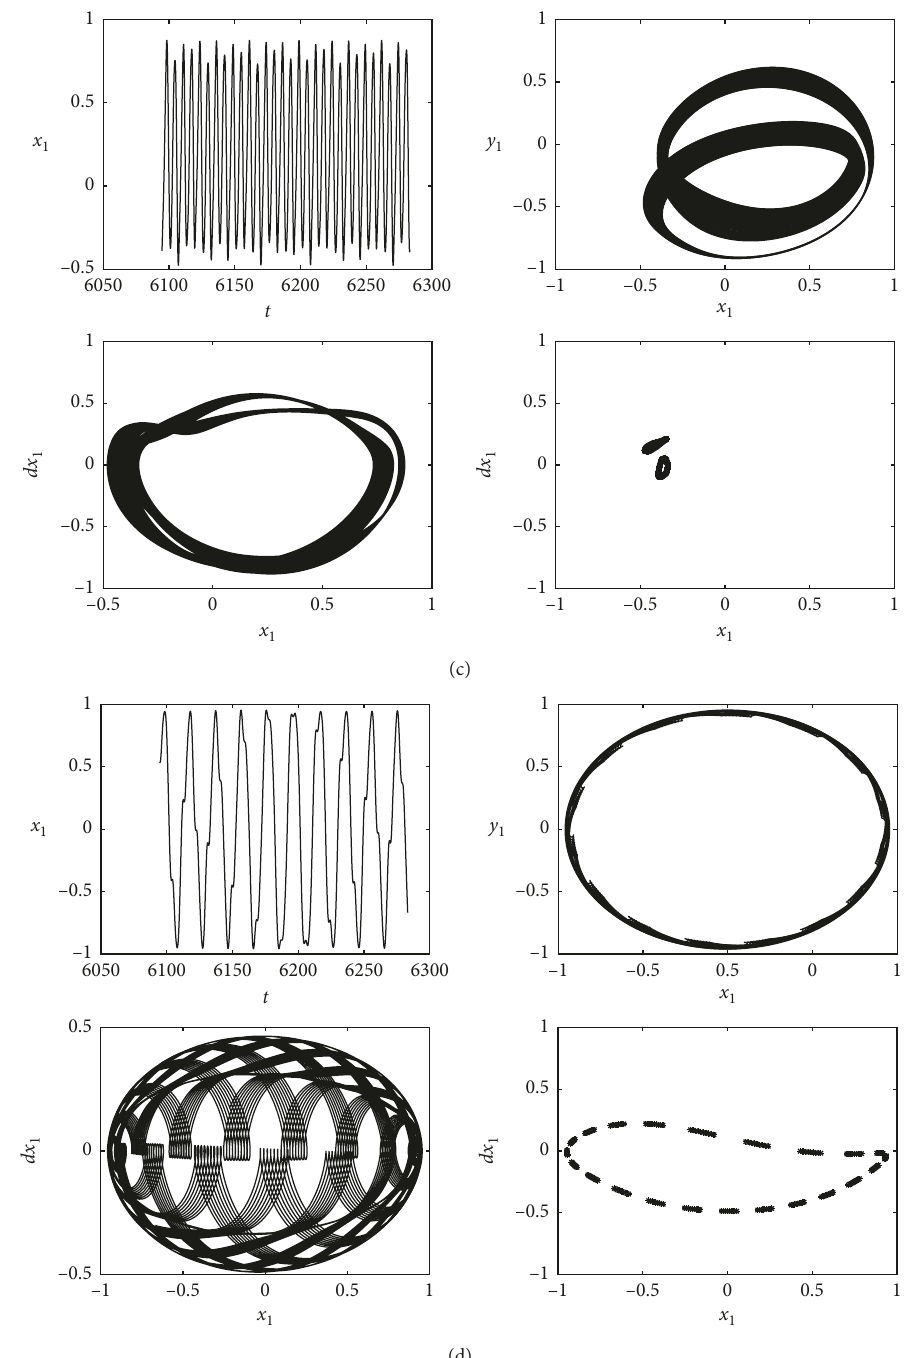
Figure 10: Response of the rotor system at different rotation speeds when b and (d) ω �